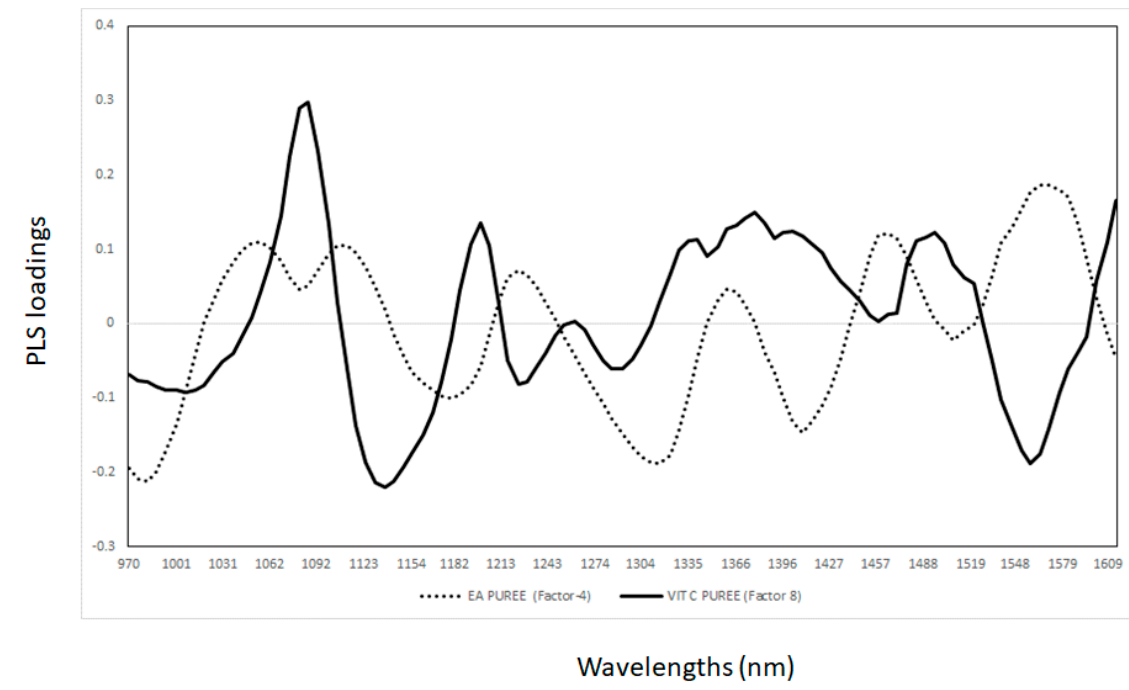
Figure 1. Partial least square loadings for the measurement of vitamin C and ellagic acid in whole Kakadu plum fruit samples.